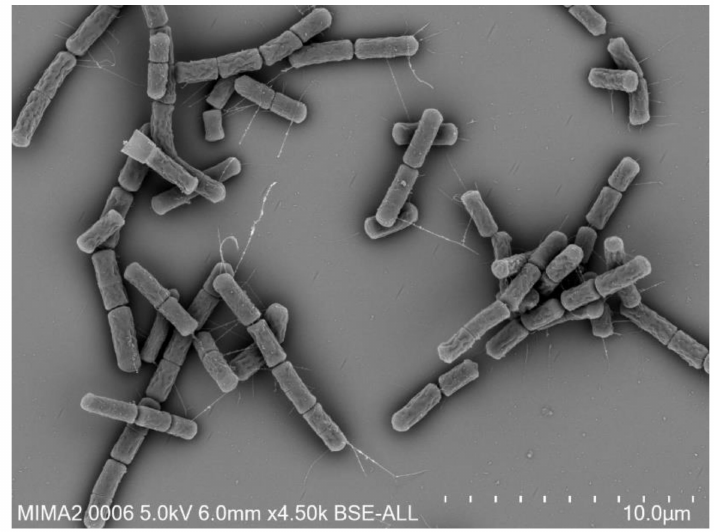
Figure 1. Scanning electron microscopy image of B. cereus